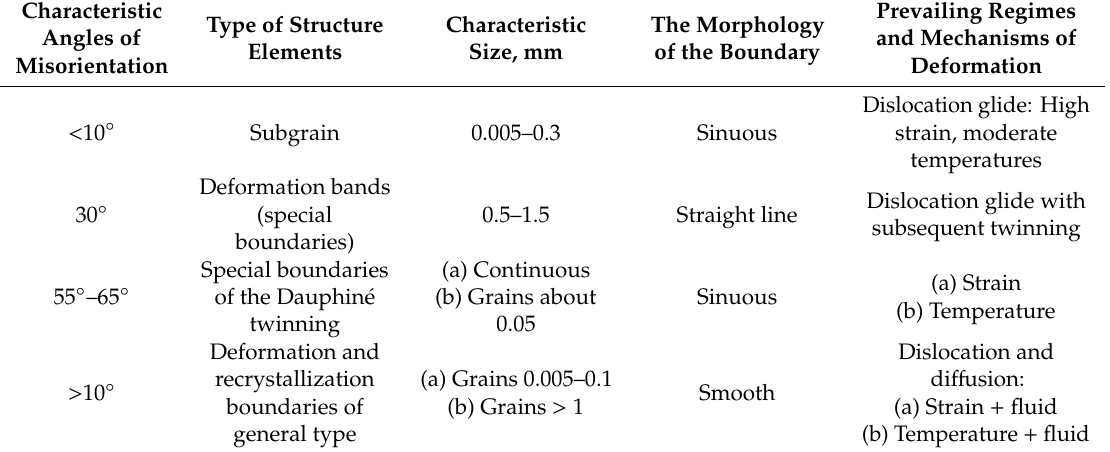
Table 2. The characteristics and schemes of typical structure